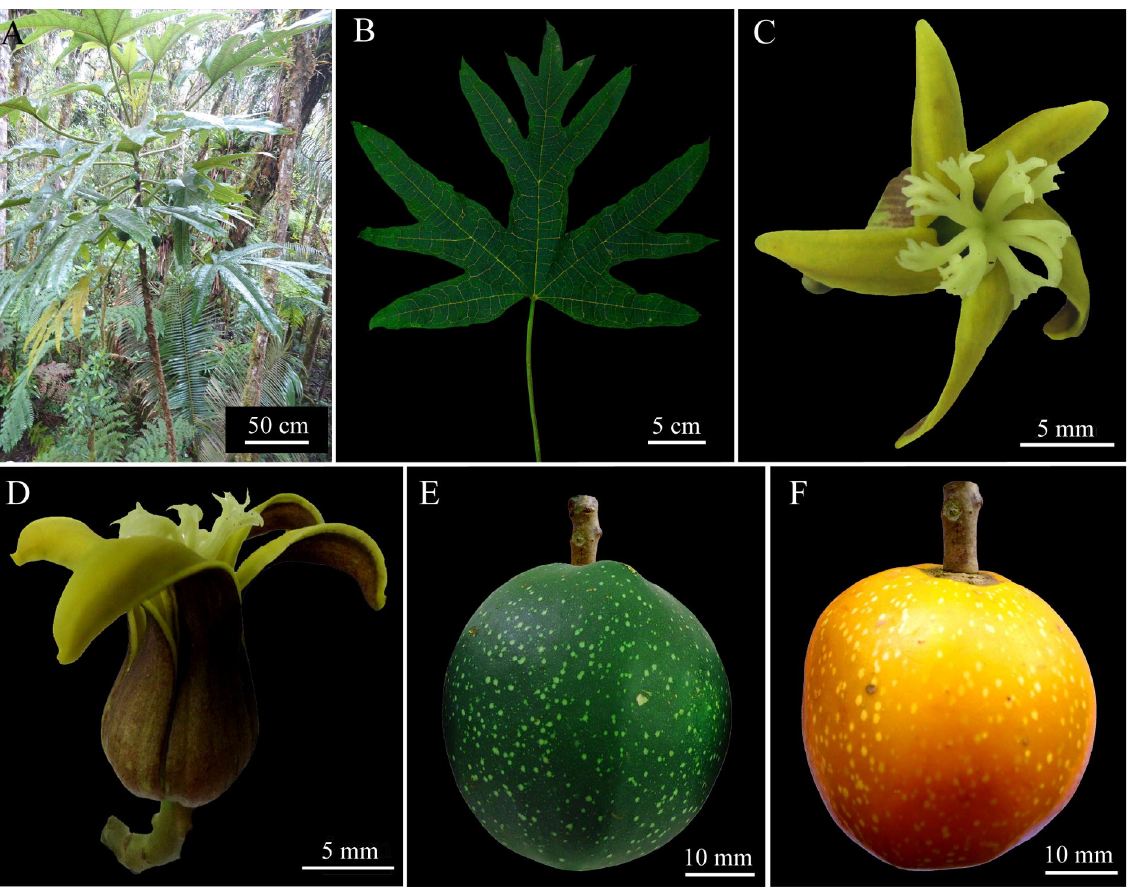
Fig 6. Morphology of Vasconcellea pentalobis sp. nov. (CHAX238). A, Habit. B, . Palmately compound leaf with four basal leaflets and a central pentalobed leafleft. C, Female flower with stigmas split in 2–3 ends. D, Dextrorotatory female flower. E, Immature fruit. F, Mature fruit.